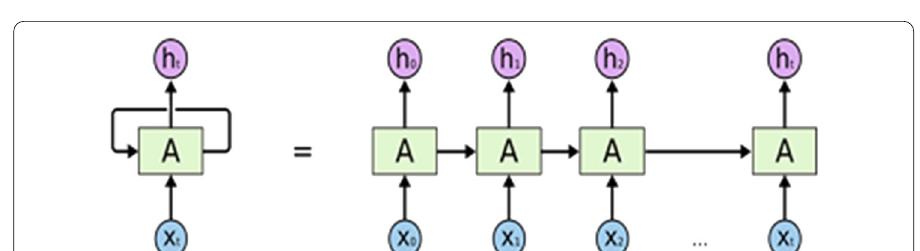
Fig. 2 Example of data visualization using data science approach